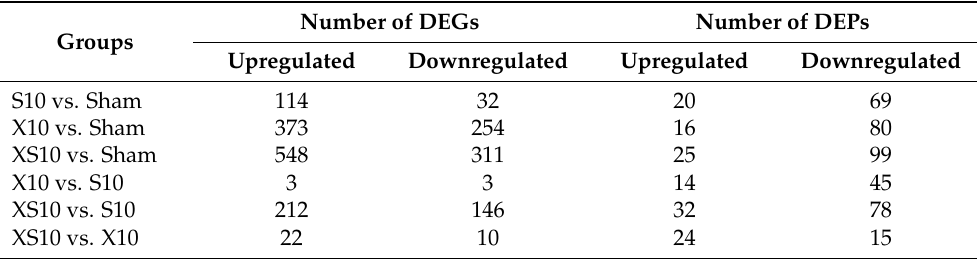
Table 1. The number of differentially expressed genes and proteins in the peripheral blood after exposure to multifrequency microwaves of 2.8 GHz and 9.3 GHz. Number of DEGs Number of DEPs Groups Upregulated Downregulated Upregulated Downregulated S10 vs. Sham 114 32 20 69 X10 vs. Sham 373 254 16 80 XS10 vs. Sham 548 311 25 99 X10 vs. S10 3 3 14 45 XS10 vs. S10 212 146 32 XS10 vs.